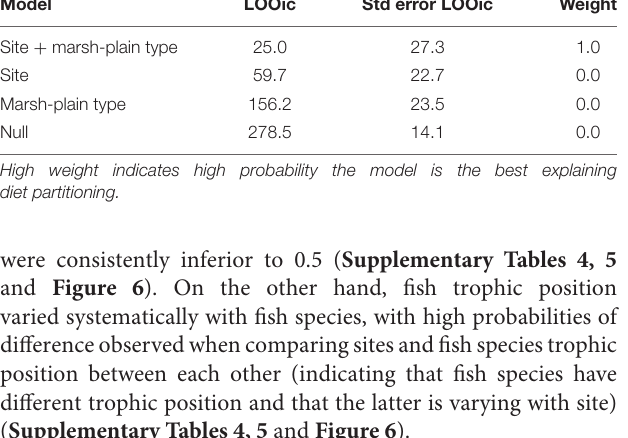
TABLE 1 | Number of samples collected (per marsh-plain type and site for predators and per site for primary producers and prey). Marsh plain type